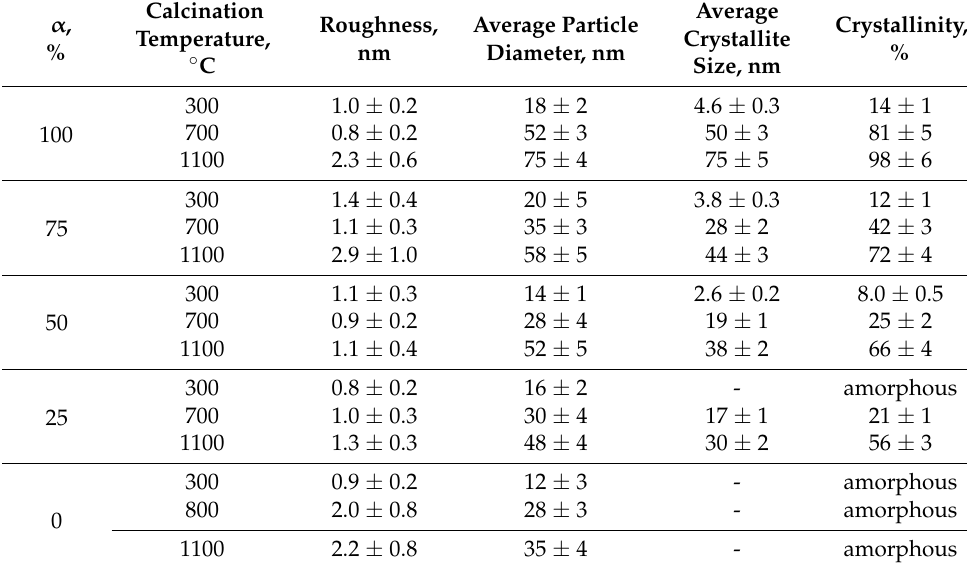
Table 1. Structural parameters of (N i0 . 6 Mn 0.4 Fe 2 O 4 ) α (SiO 2 ) 100 − α NCs calculated from AFM and XRD